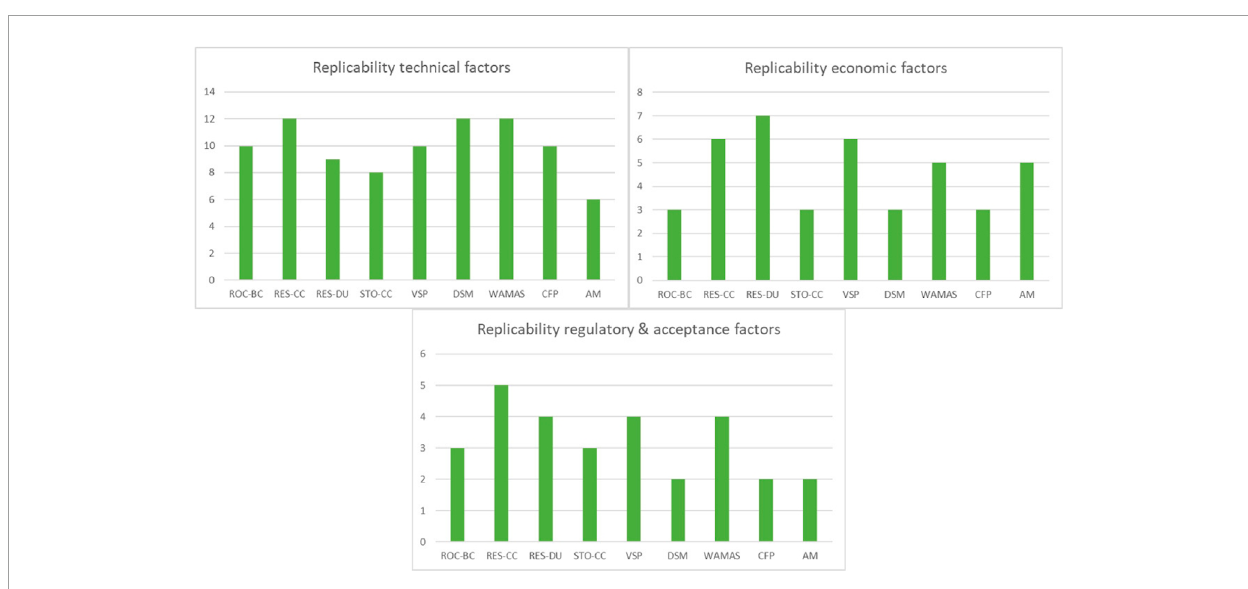
FIGURE 12 Total quantification of replicability factors per CROSSBOW